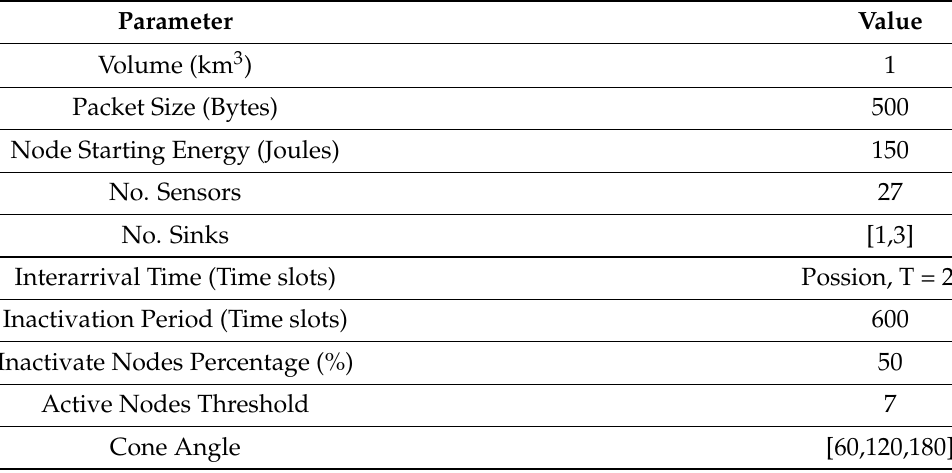
Figure 8. A 3D view of the system model. Table 1. The simulation